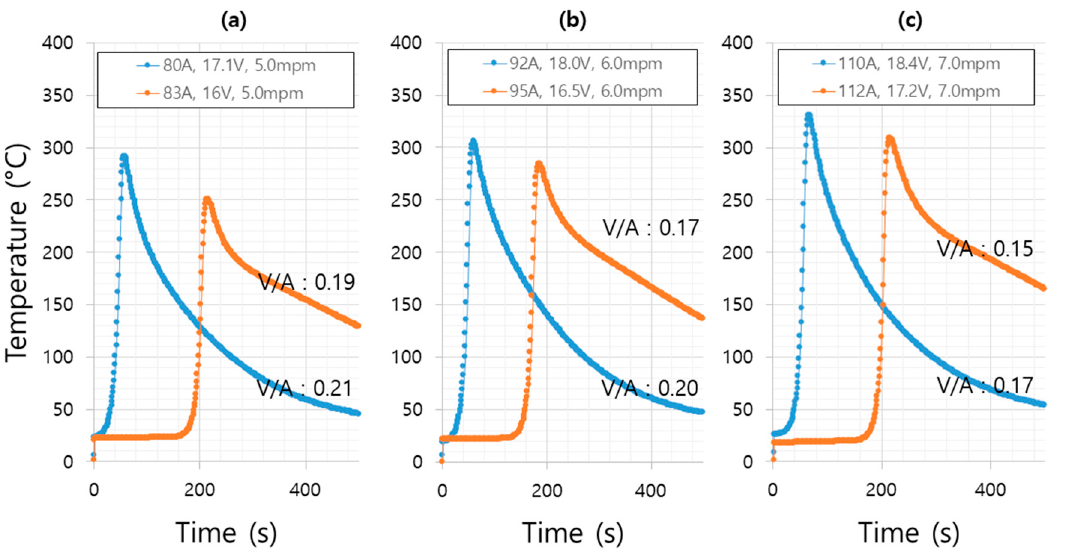
Figure 8. Variation of temperature profile on the substrate according to the current and voltage ratio.